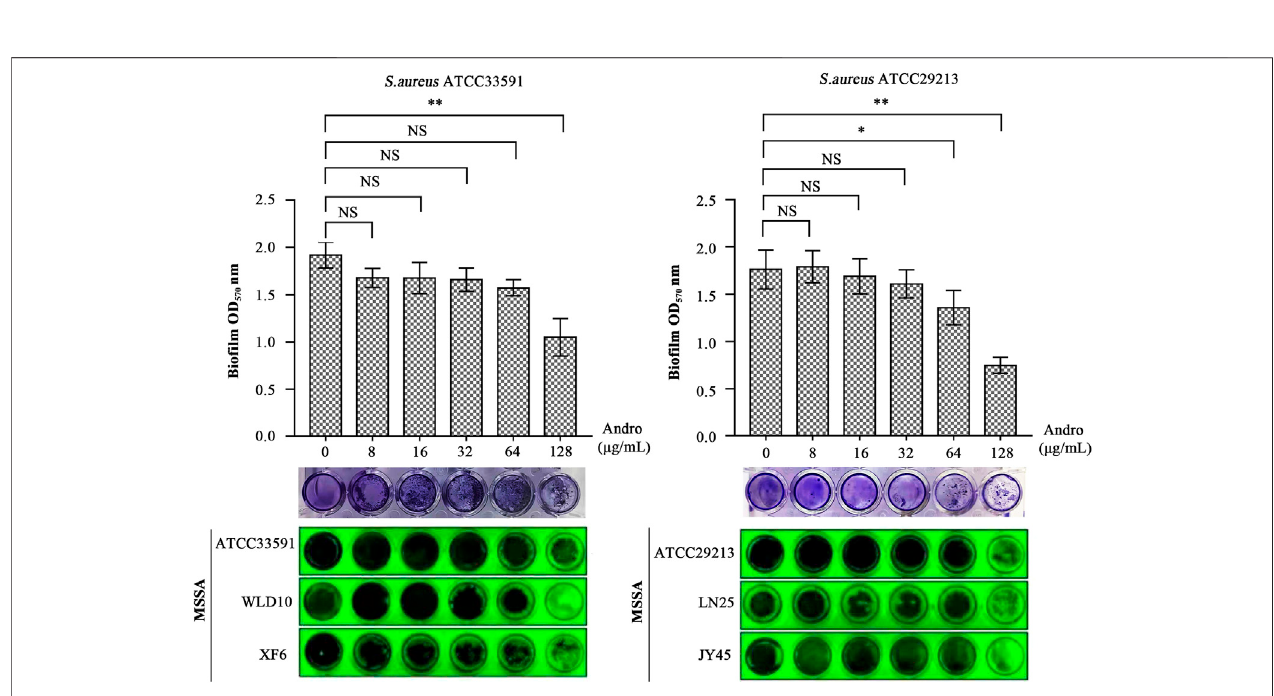
FIGURE 7 | Inhibition of the S. aureus bio fi lm by QEN, indicating that QEN counld signi fi cantly inhibits bio fi lm formation when QEN concentration was 128 μ g/ml.